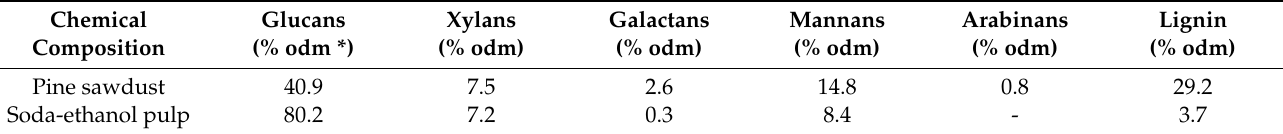
Table 2. Pine sawdust and soda-ethanol pulp chemical